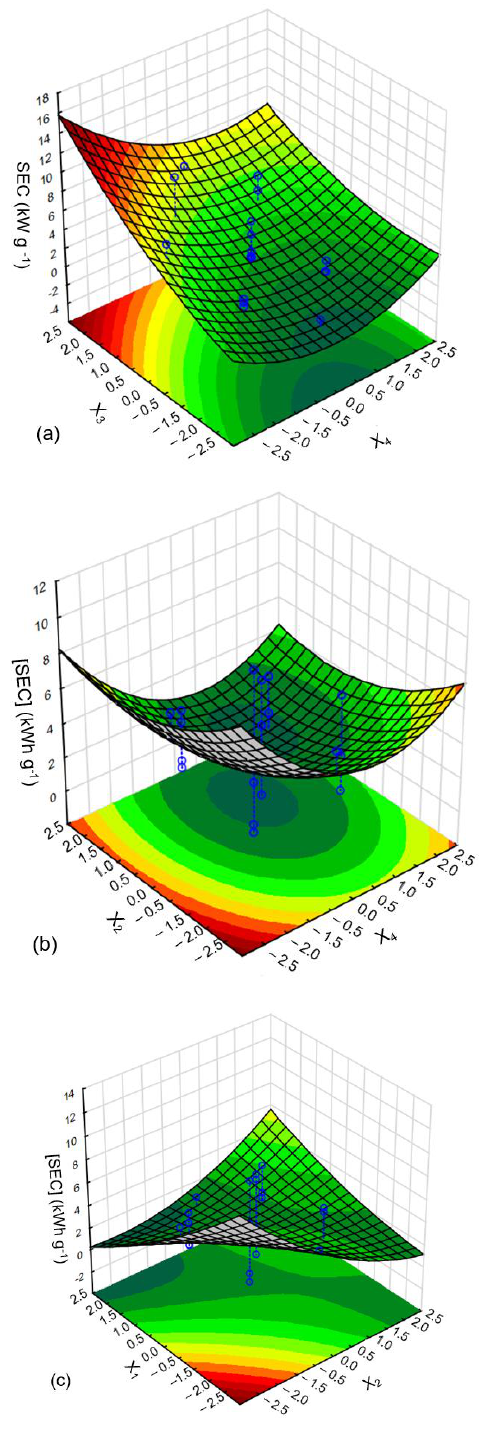
Figure 2. Three-dimensional surface plot of the specific energy consumption ( SEC ) as a function of the independent variables X 1 ([GES] 0 ), X 2 [LNG] 0 , X 3 ( j ) (), and X 4 ([NaCl] 0 ) ). Each plot highlights the effects of two variables on the SEC with the other two variables fixed at their central point conditions: (a) X 3 ( j ) and X 4 ([NaCl] 0 ); (b) X 2 [LNG] 0 and X 4 ([NaCl] 0 );c) X 1 ([GES] 0 ) and X 2 [LNG] 0 . As shown in Figure 2a, at the central levels of j = 32.5 mA cm 2 ( X 3 ) and [NaCl] 0 = 0.07 mol L −1 ( X 4 ), the average response (SEC) was estimated to increase for high levels of X 3 and low levels of X 4 . This observation was also verified using the model (Equation (9)), in